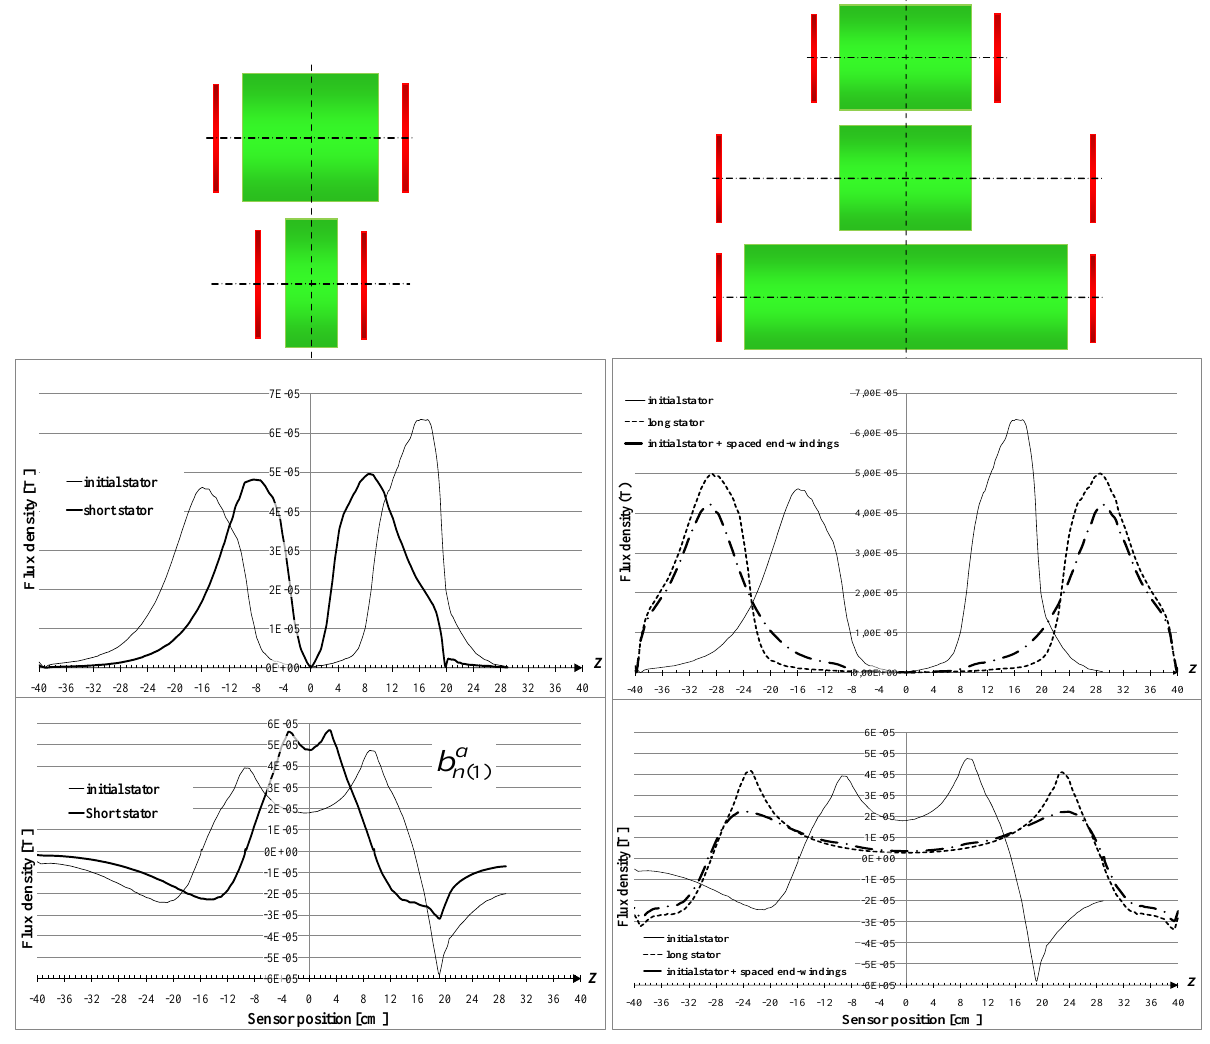
Figure 11. Variations of the normal a with Z - Influence of the stator length and of the end-winding